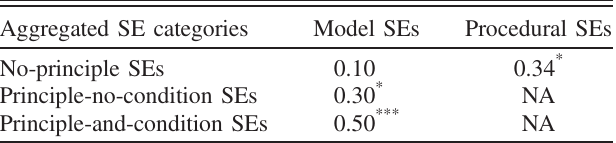
TABLE X. Correlations between the aggregated SE measures and the post-test problem-solving score. Note that N ¼ 54 for all